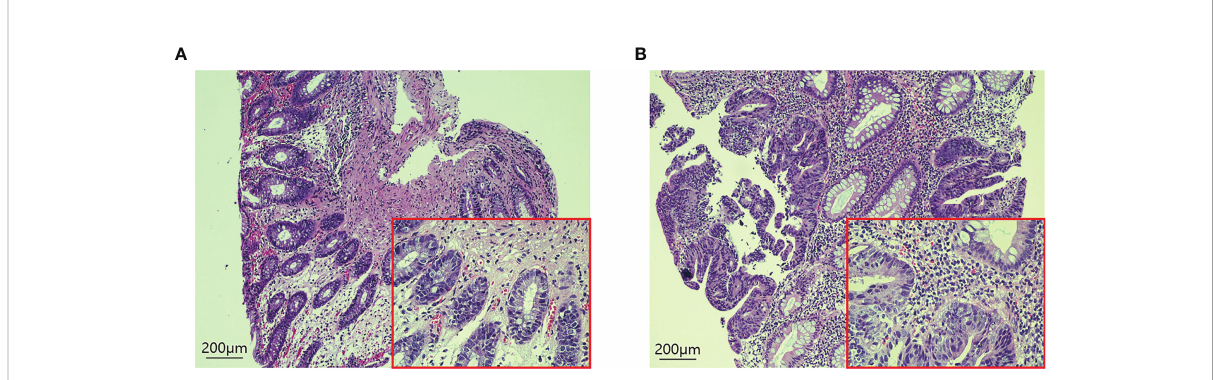
FIGURE 6 H-E staining of tumor tissues in CRC patients before and 48 hours after PDT. (A) Before PDT, a small number of immune cells were in fi ltrated around the tumor tissue. (B) 48h after PDT, the number of immune cells in tumor tissue increased signi fi cantly.